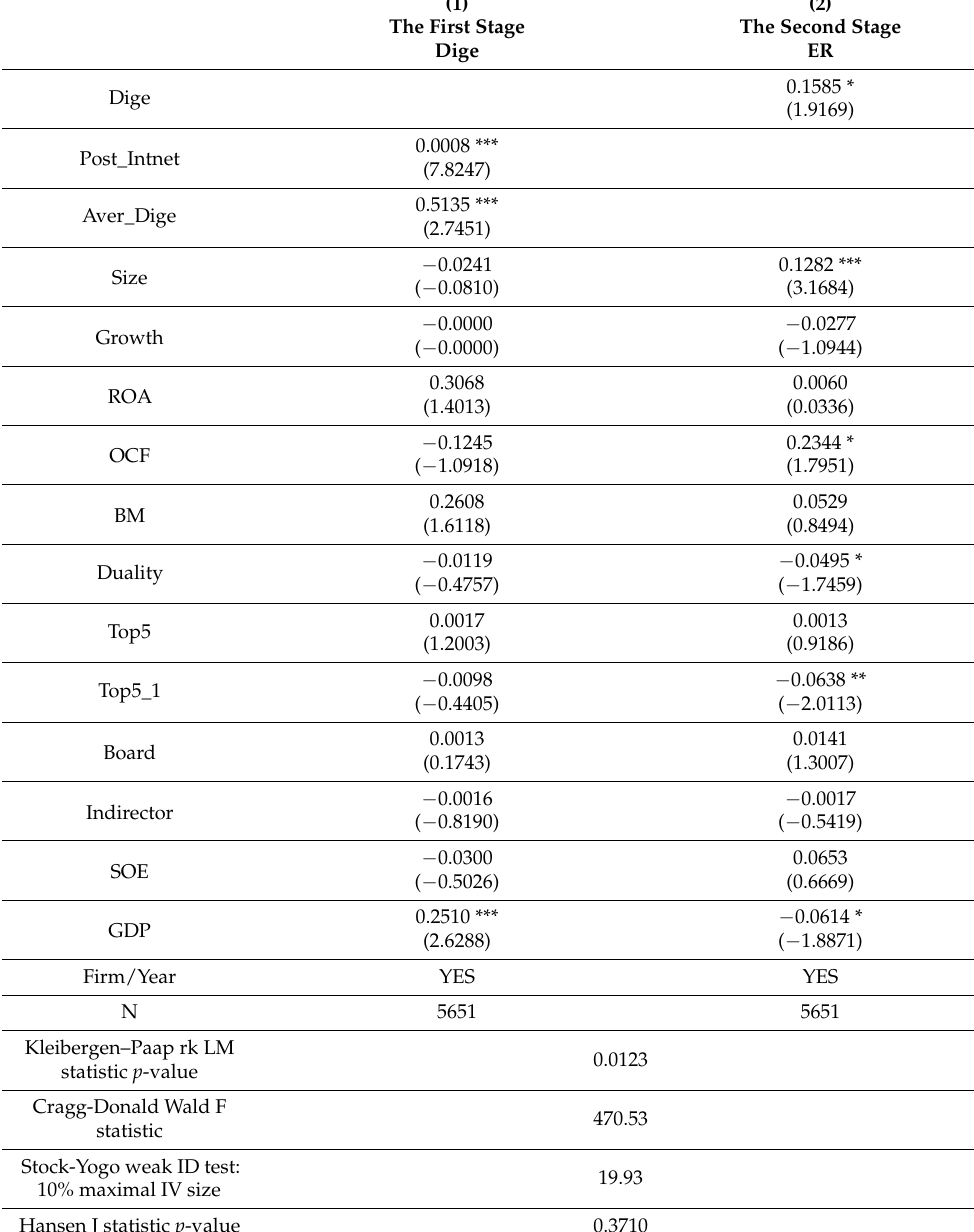
Table 4. Instrumental variable